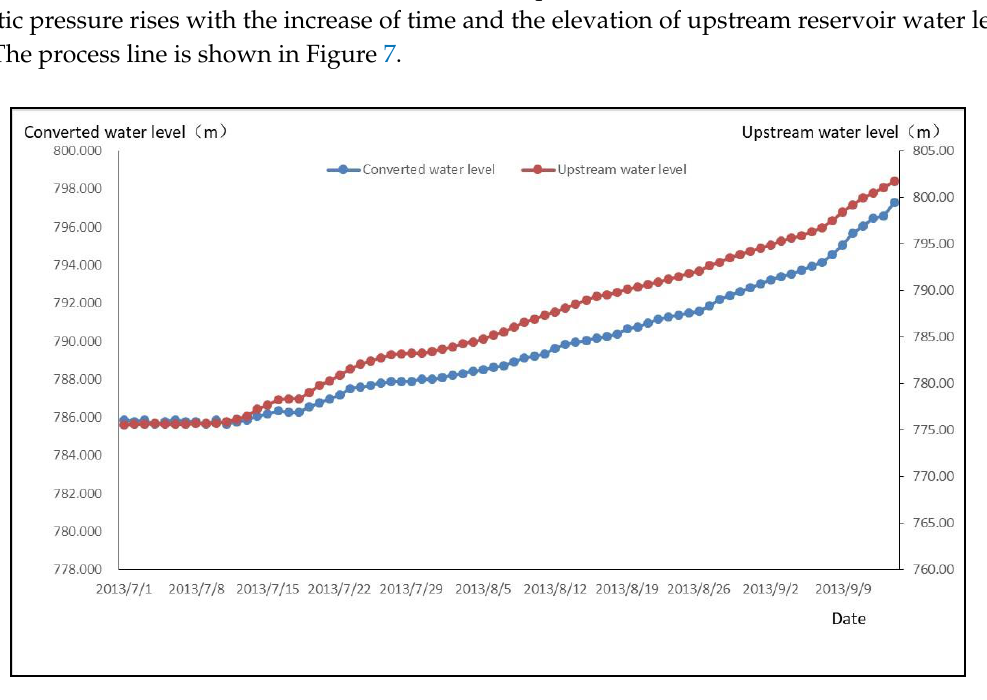
Figure 7. Osmotic Pressure and Upstream Reservoir Level Timing Process Diagram.